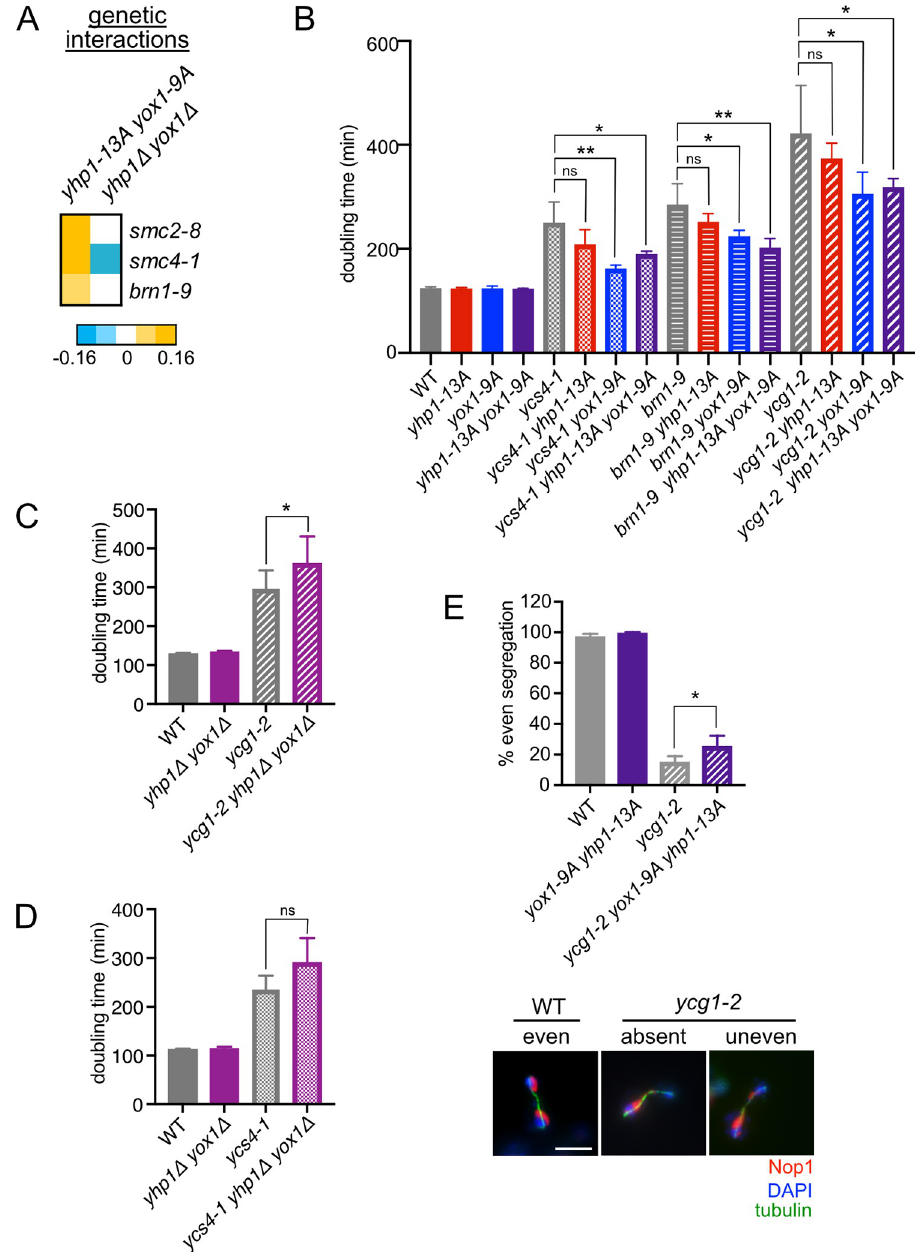
Fig 4. Yhp1/Yox1 phosphomutants improve proliferation of condensin mutant strains. (A) Genetic interactions between double mutant query strains and conditional alleles of condensin genes, from SGA screens described in Fig 1. (B) Doubling times of strains with the indicated genotypes grown in rich media at 28˚C. Shown are an average of n = 3–6 replicates, error bars indicate standard deviations. (C) Average doubling times of the indicated strains grown at 28˚C for n = 4–10 replicates, error bars indicate standard deviations. (D) Average doubling times of the indicated strains grown at 30˚C for n = 3–7 replicates, error bars indicate standard deviations. For parts (B-D) significance was tested using an unpaired t-test, � p < 0.05, �� p < 0.005, ns = nonsignificant. (E) Quantitation of nucleolar segregation in the indicated strains. Nop1 segregation was scored in at least 100 cells in n = 3 replicate experiments. Shown is average percentage of even Nop1 segregation, error bars indicate standard deviations. Significance was tested using a paired t = test, � p < 0.05. Representative images are shown comparing even segregation in a wild type (WT) strain to absent and uneven segregation that occur most frequently in ycg1-2 strains. Scale bar represents 5 μ M.